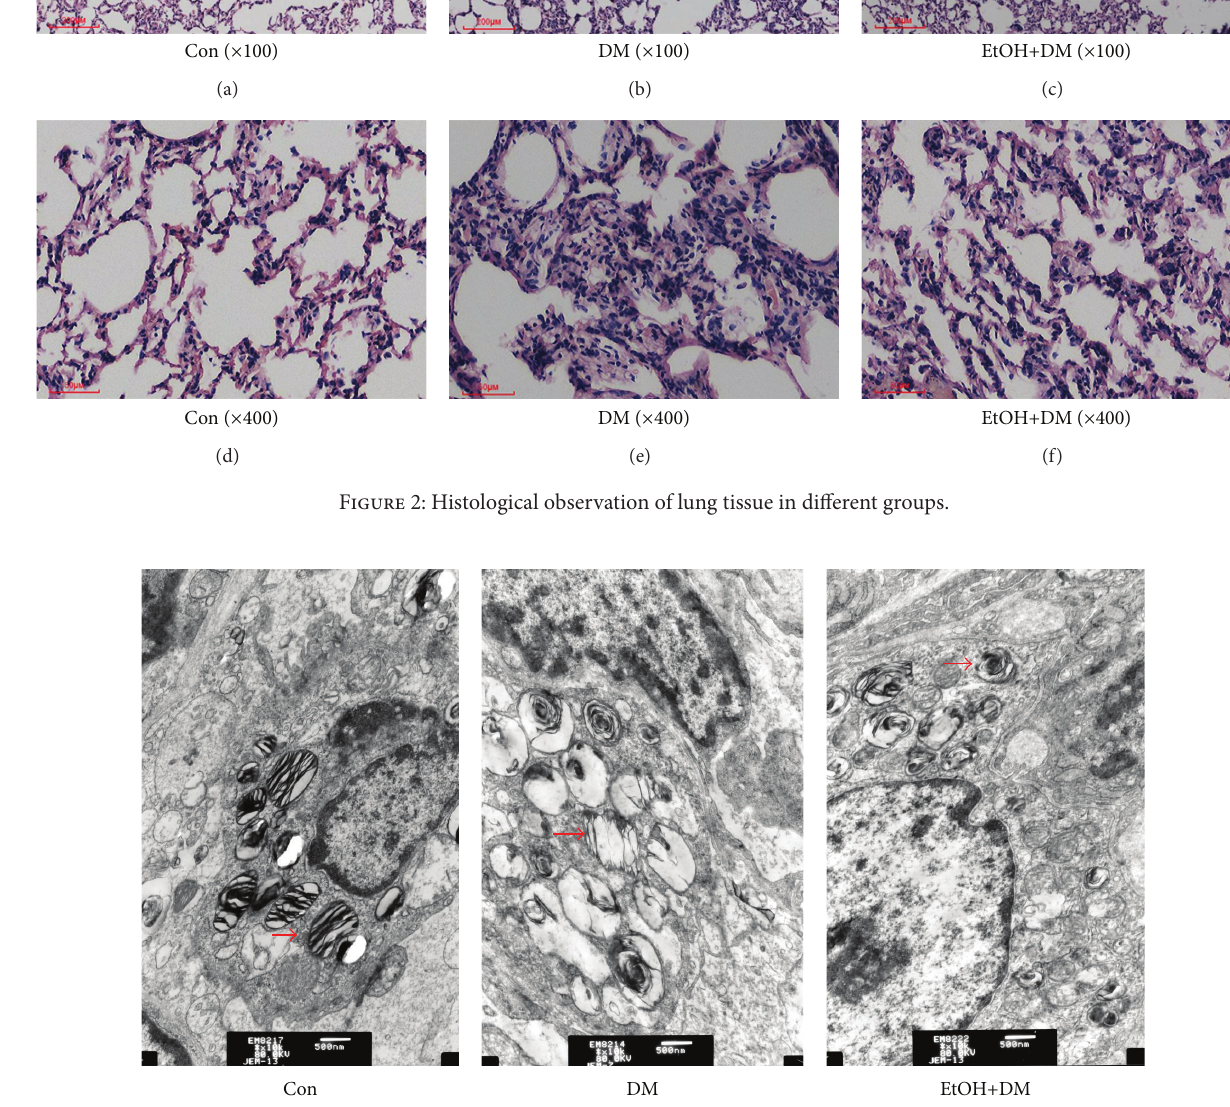
of diabetes-related complications including lung